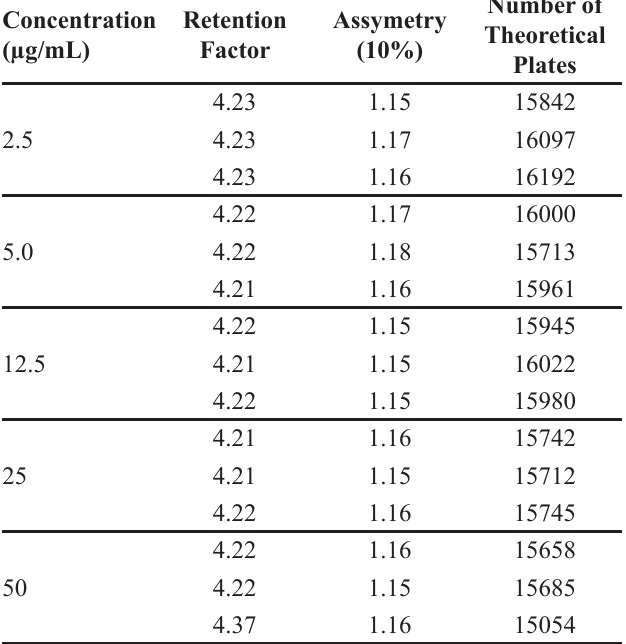
TABLE III - Evaluation parameters values to all standard solution